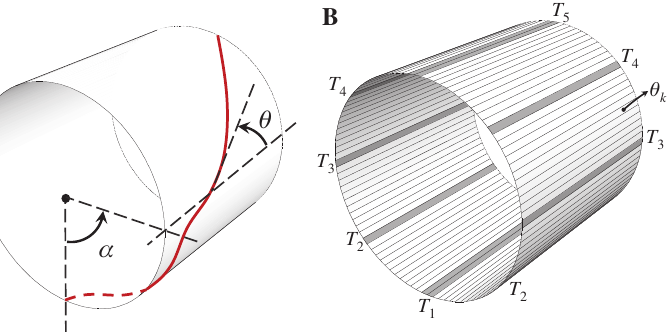
Figure 2: (A) Fiber path in a VS ply and (B) piece-wise constant model for approximating the varying orientation angles of fibers in VS layers.